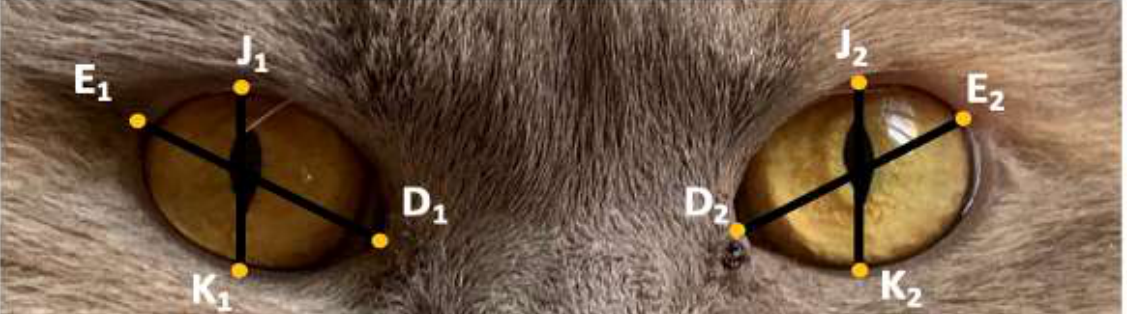
Figure 4. Novel eye-shape method. Eye height (JK; average of J 1 K 1 & J 2 K 2 , eye width (DE; average of D 1 E 1 & D 2 E 2 ).